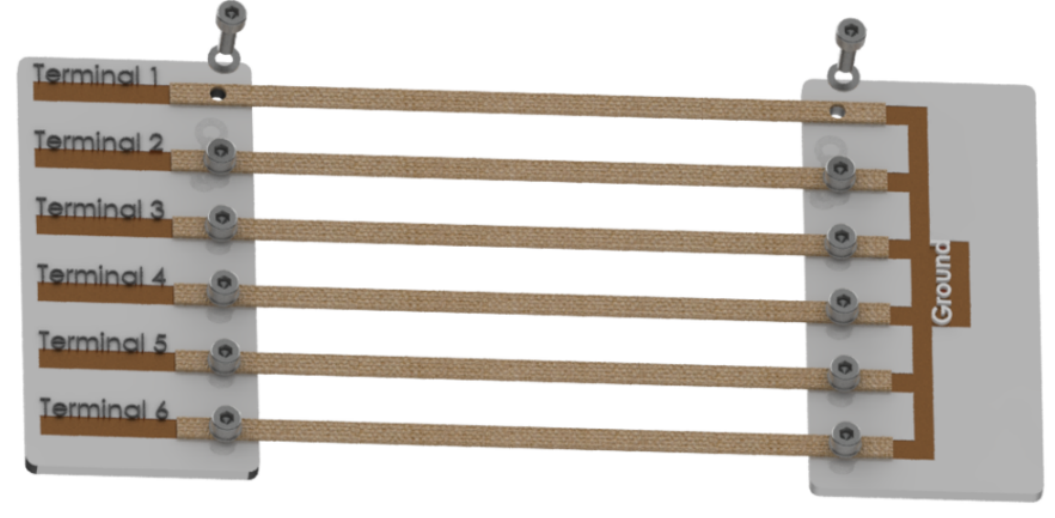
Figure 4. Disassembled view of band to stretch machine